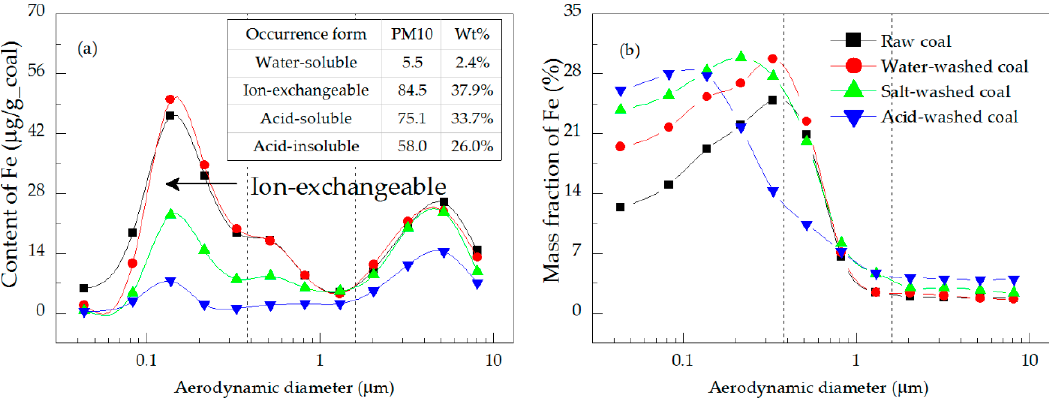
Figure 8. Distributions of the ( a ) content and ( b ) mass fraction of Fe in the PM.